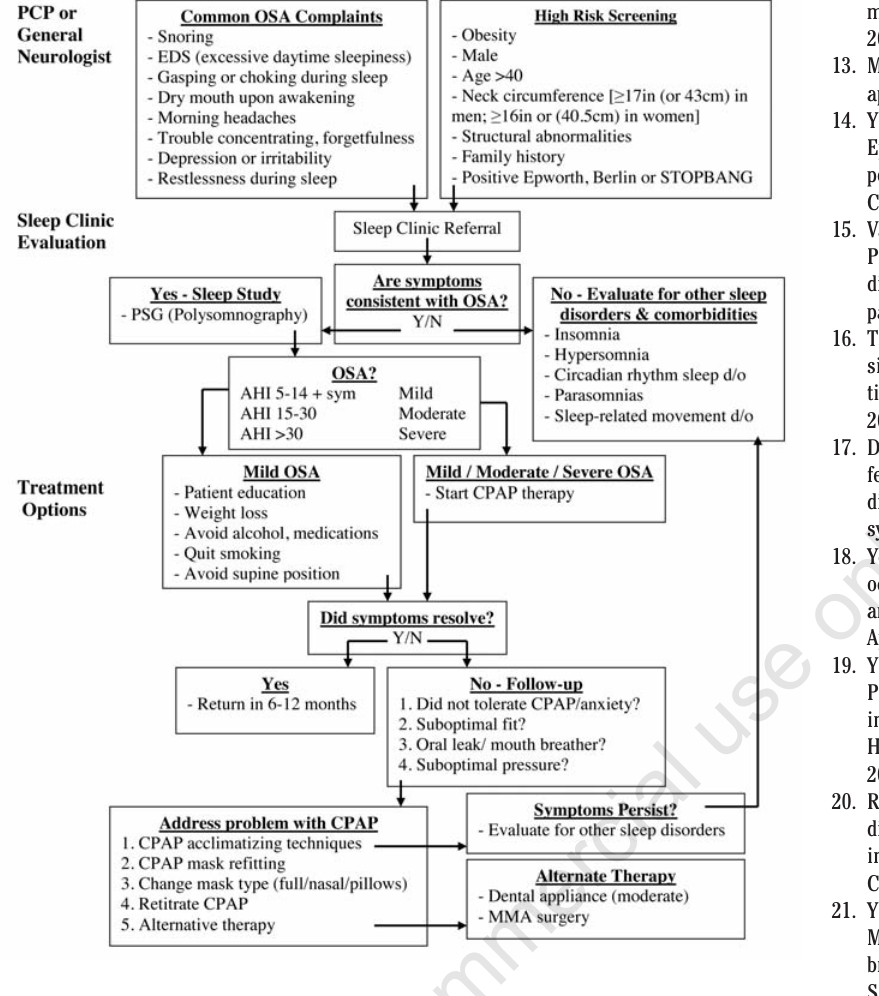
Figure 5. Evaluation of OSA. Approach to initiation, management, and follow-up of treat-